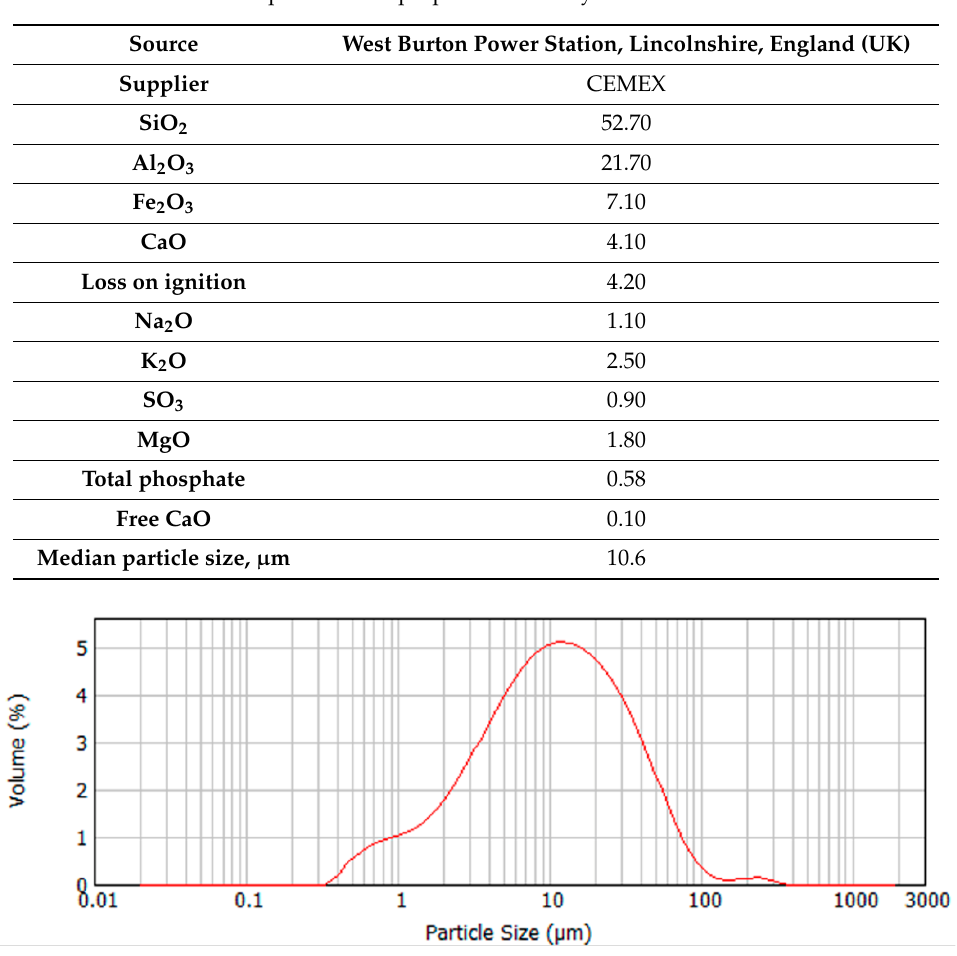
Figure 2. Particle size distribution of the fly ash.